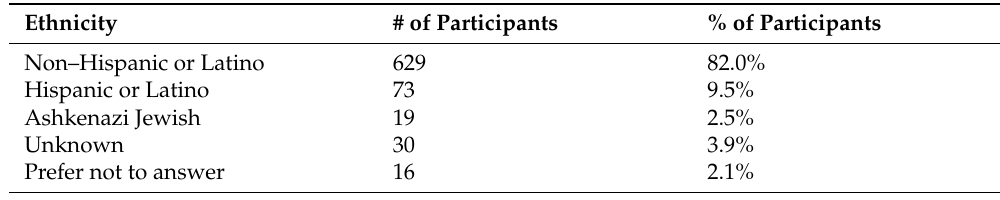
Table 7. Ethnicity of participants within the Global PWS Registry.